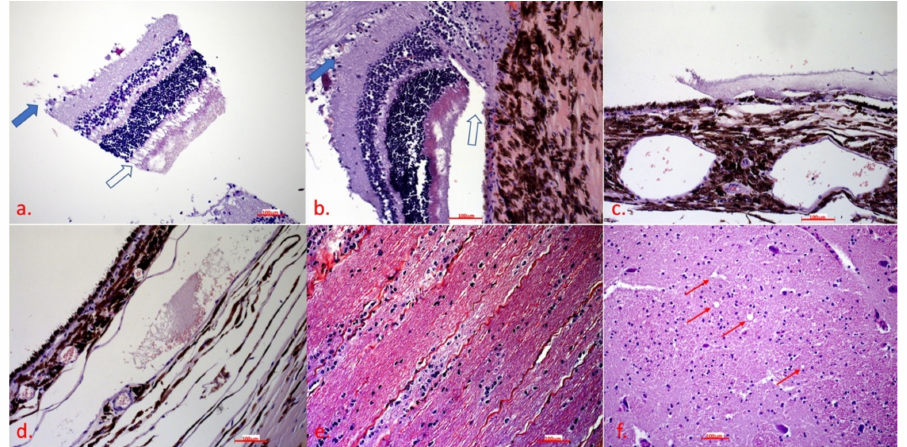
Figure 5. Histopathological examination reveals significant lesions in the eye bulb: ( a ) retina—the bold arrow shows apoptosis of the ganglion cell layer, the blank arrow shows apoptosis of the rod and cone layer; ( b ) optic disc—the bold arrow shows apoptosis of the ganglion cell layer and the optic nerve, the blank arrow shows ablation of the retinae; ( c ) subchoroidal layer—oedema causing retinal ablation; ( d ) choroidal layer—oedema and haemorrhage; ( e ) optic nerve—apoptosis within the optic nerve and microgliosis as a reparative process; ( f ) brain, spongiform-like lesion—the red arrows show vacuoles. In all the figures from ( a ) to ( f ), the scale bar corresponds to 100 µ m (20 × magnification).